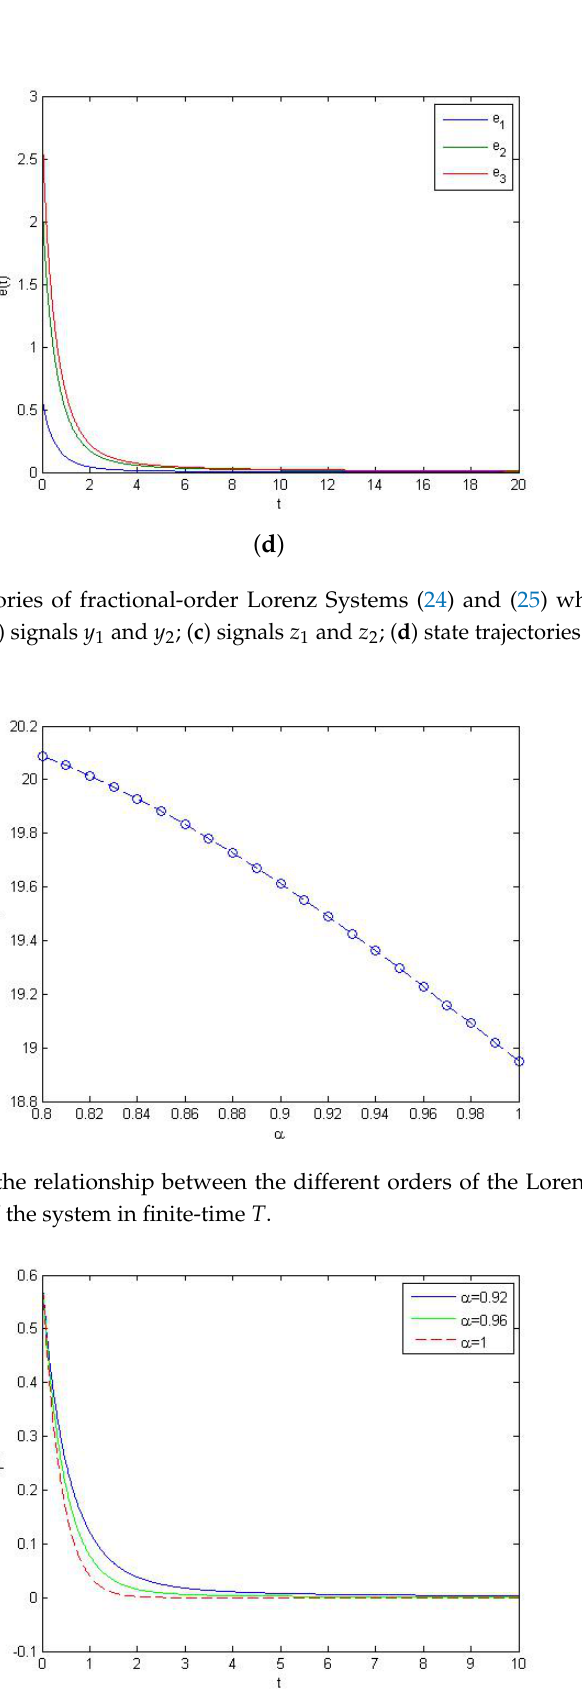
Figure 5. The error state curves between the drive system and response system with different orders q = 0.92, 0.96,